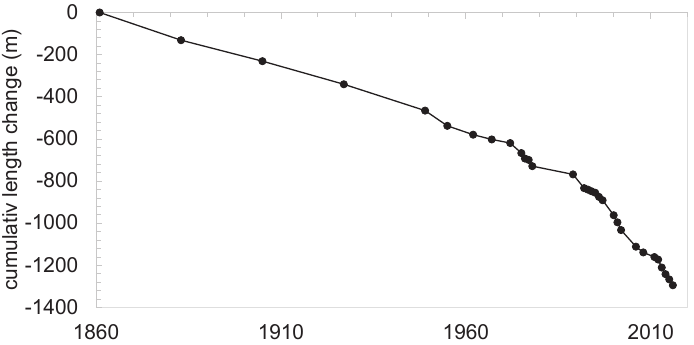
Figure 3. Cumulative glacier length change of Golubin since the 1860s. Data downloaded from the World Glacier Monitoring Service (WGMS)